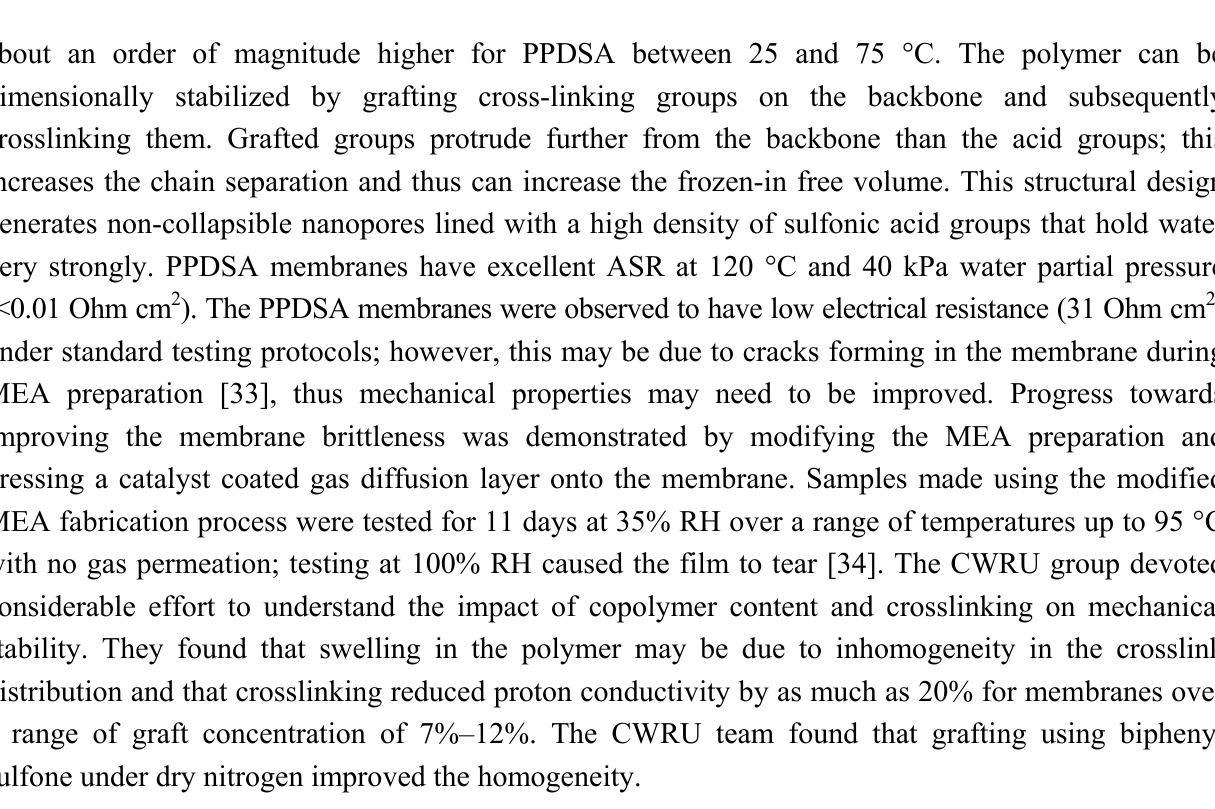
Figure 4. Schematic representation of the approach taken at the Case Western Reserve University. In ( a ) the unmodified polymers pack close together; ( b ) shows the effect of adding angled copolymers which forces the chains apart over the whole length creating permanent nano-pores lined with sulfonic acid groups; and ( c ) shows the effect of adding bulky monomers creating nano-pores lined with sulfonic acid groups